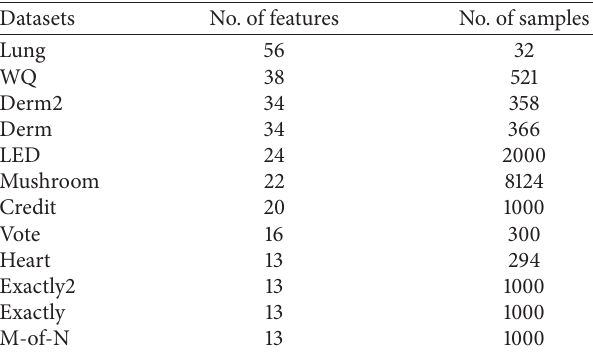
Table 1: Dataset characteristics.